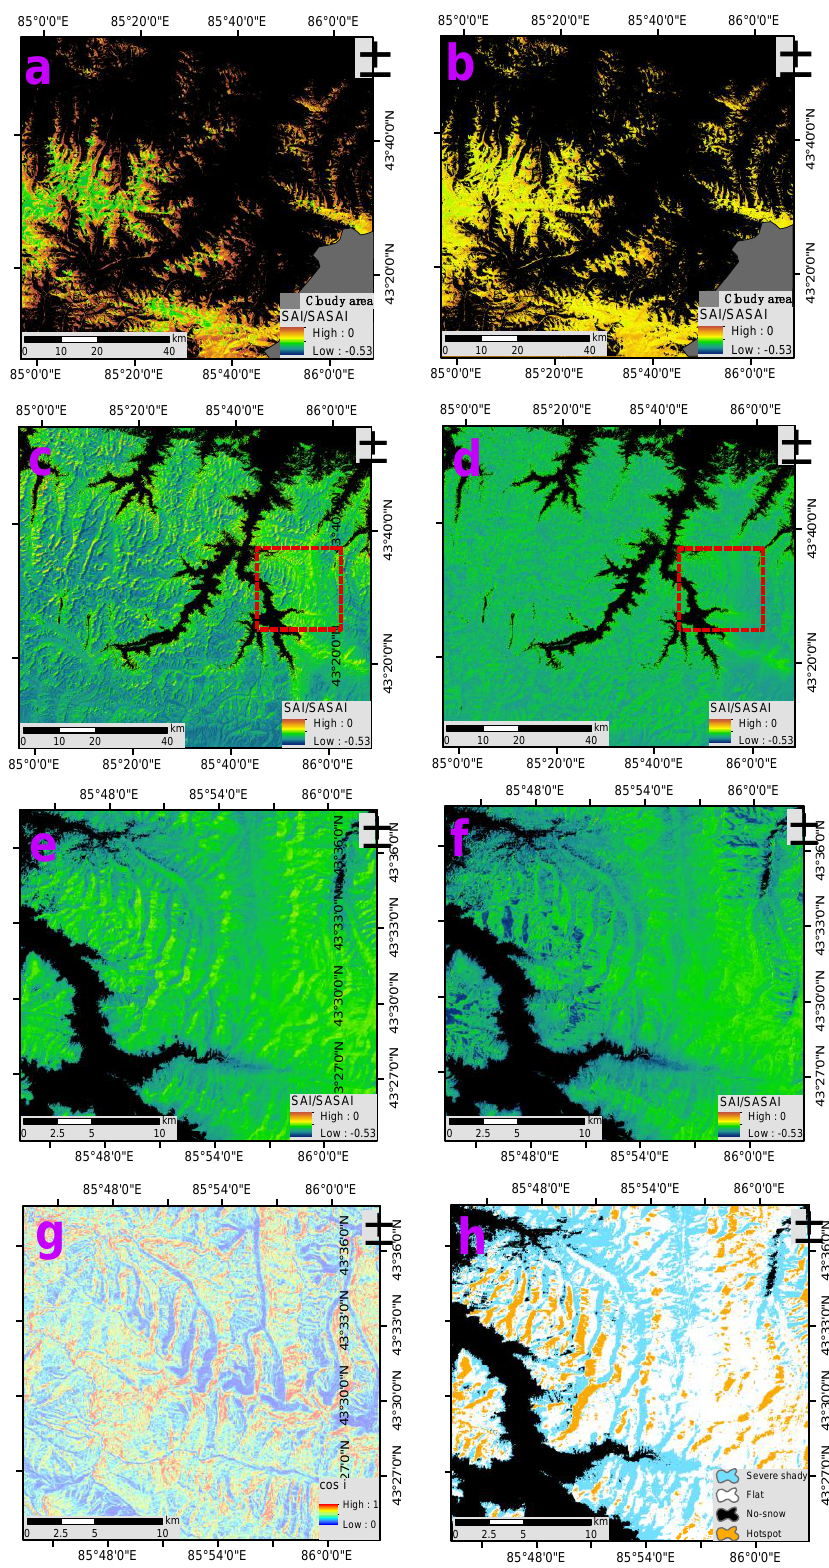
Figure 9. The comparison of the SAI ( a , c ) and SASAI ( b , d ) maps on 6 and 9 April 2014; the enlarged SAI ( e ) and SASAI ( f ) on 9 April 2014 and the distribution of Cos i ( g ) and classified terrain types as shaded, flat, and hot spot areas ( h ).